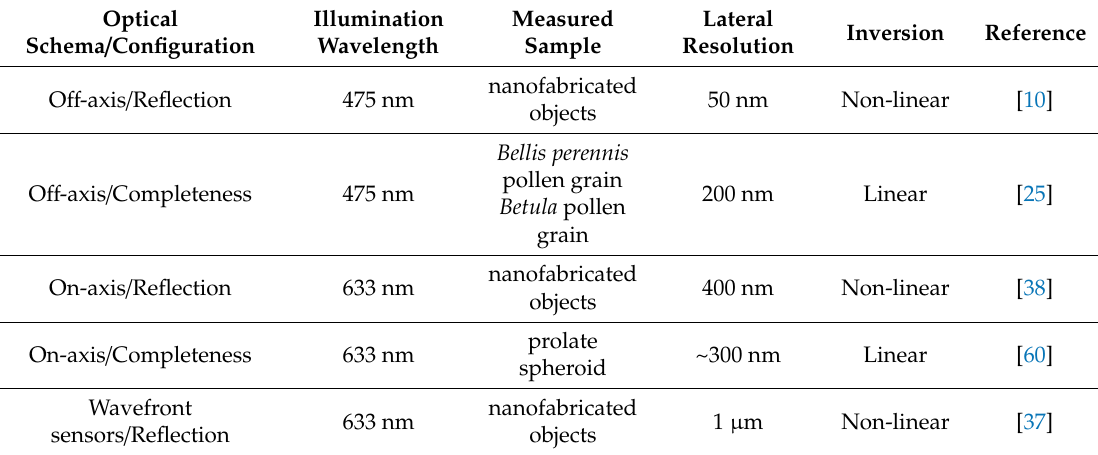
Table 1. Recent progress of tomographic di ff ractive microscopy TDM